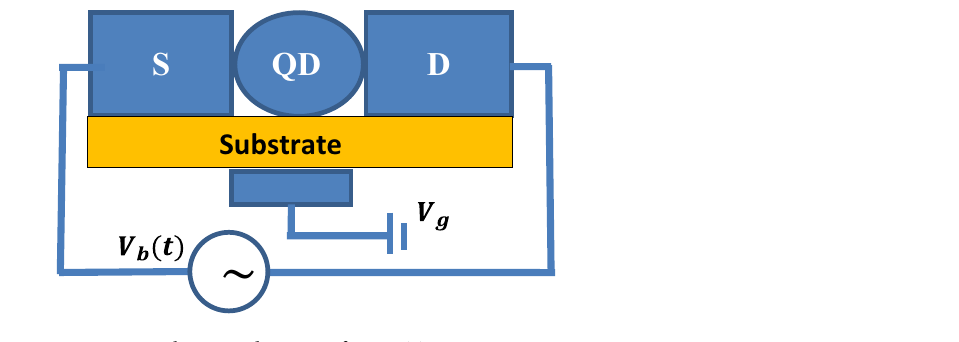
Figure 1. Schematic diagram of an SMT